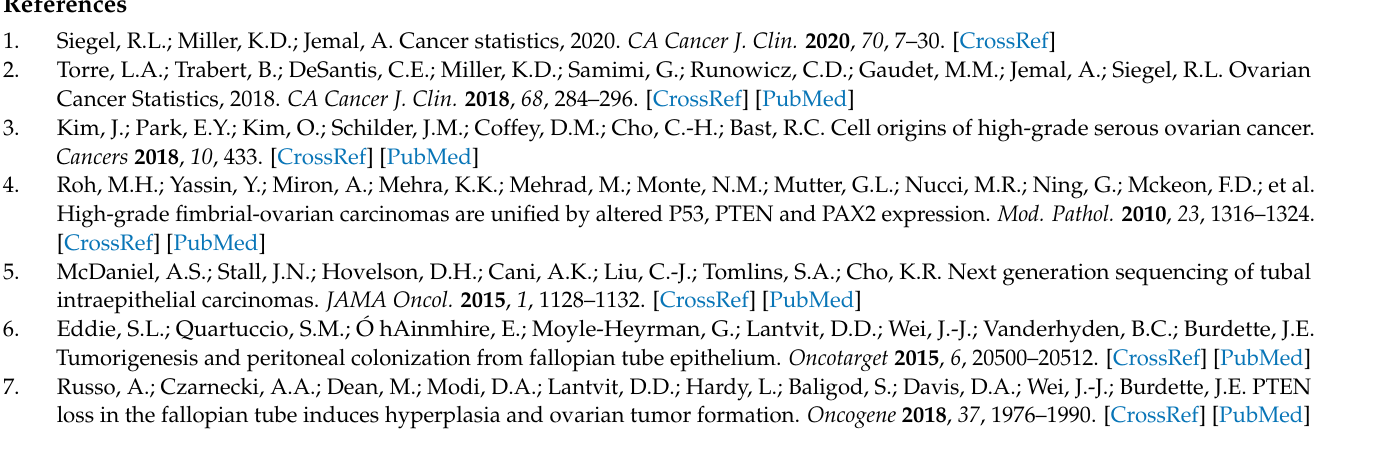
Figure S2: MOE:WT and MOE:SCOUTs express equivalent concentrations of total- and phospho-ERK, Figure S3: MEK inhibitor U0126 does not reverse androgen induced invasion through Matrigel, Figure S4: Validation of testosterone presence, Figure S5: Uncropped images of western blots from various figures, Table S1: Antibodies used for immunoblotting, Table S2: Sequences of primers used for